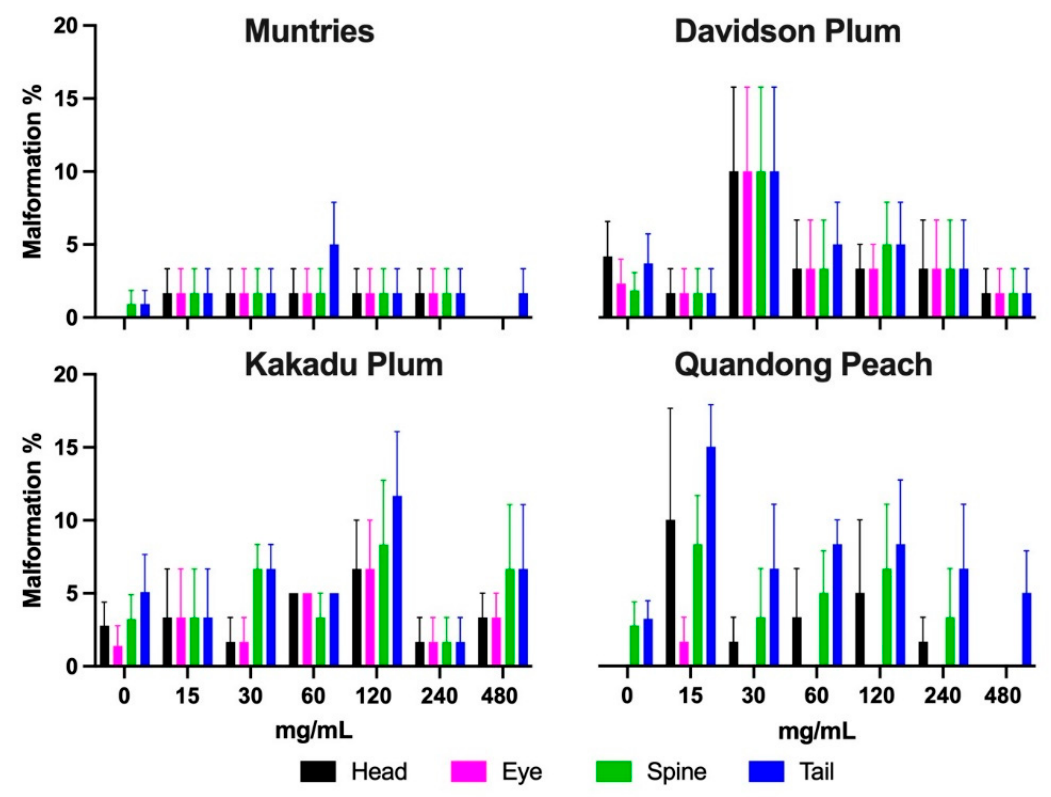
Figure 7. Malformations were observed in zebrafish exposed during 96 h post-fertilization to different concentrations of Kakadu plum, Davidson plum, quandong peach, and muntries. No statistically significant difference was observed, and the data represent the mean ± SEM.